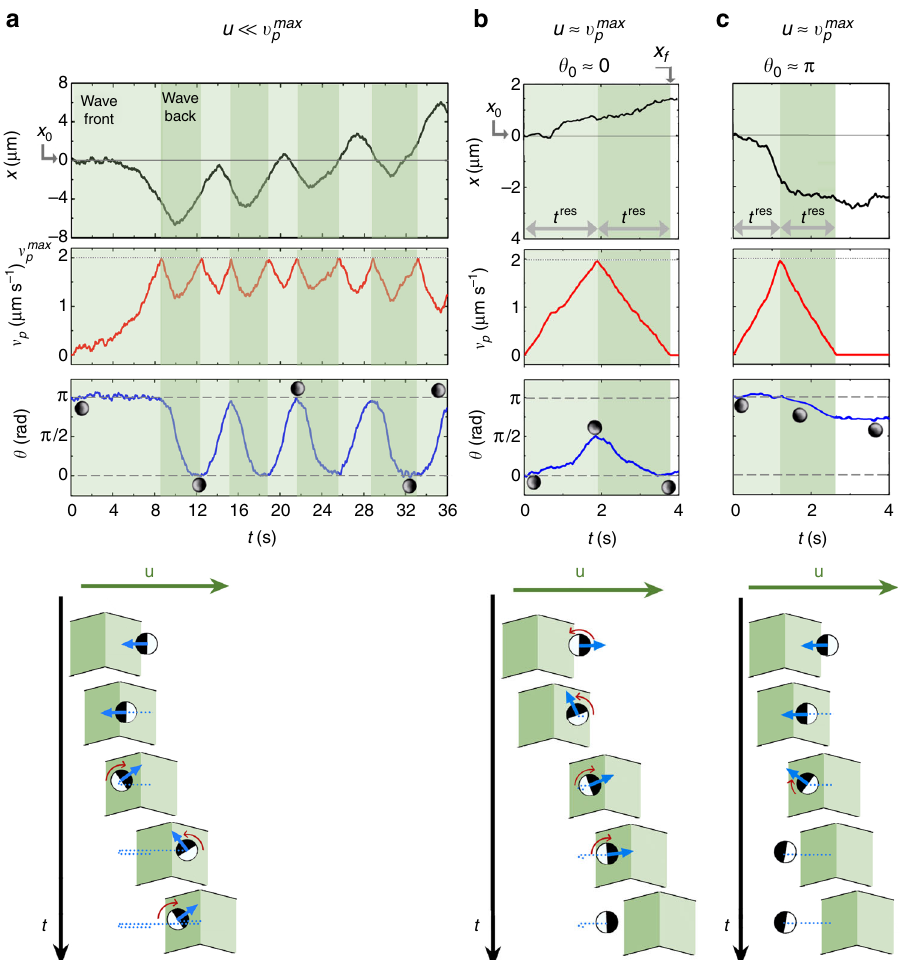
= 2 μ m/s, u = 0.25 μ m/s. b u (cid:4) v max , v max p p , and θ and schematic representation of the AP ’ s response to the traveling p